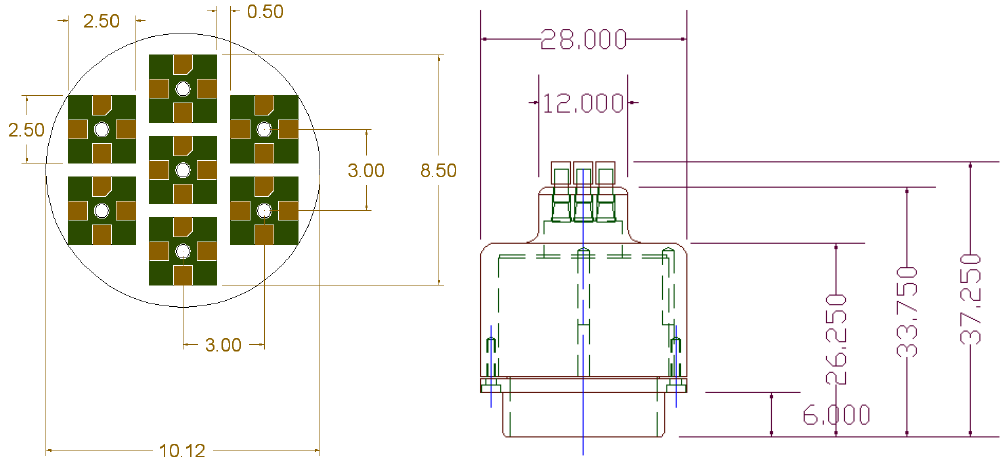
Figure 4. PSRP Dimensions (unit: mm).